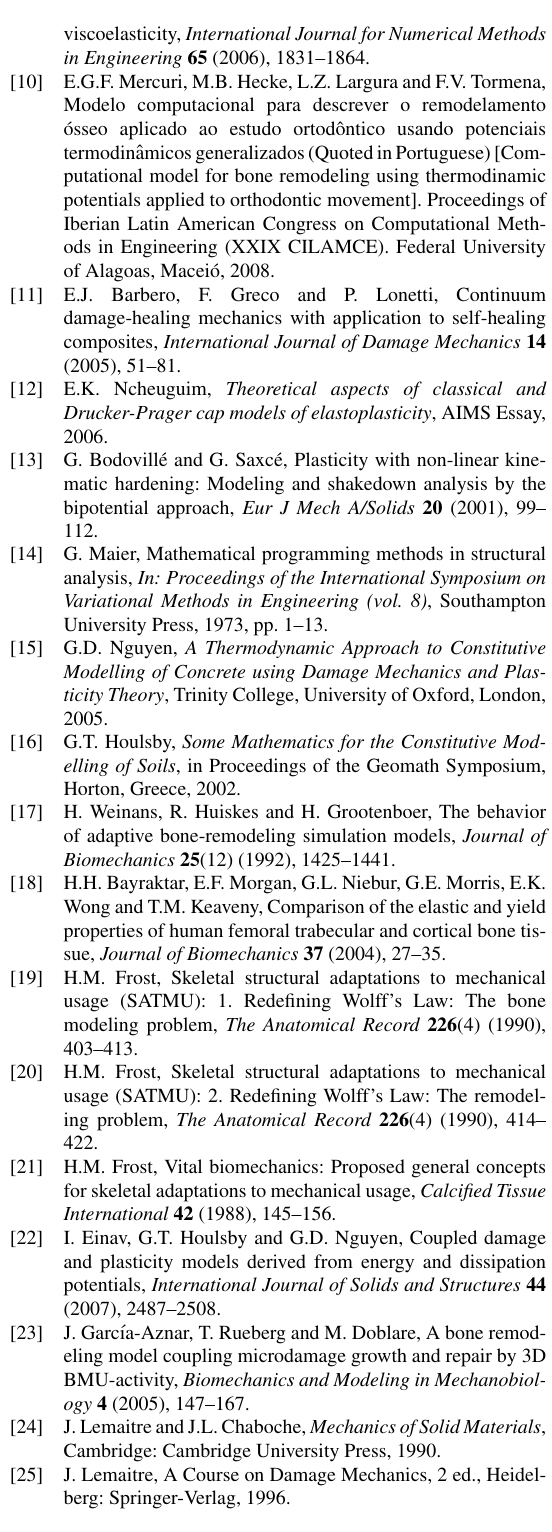
F.V. Tormena et al. / A bone remodelling model based on generalised thermodynamic potentials